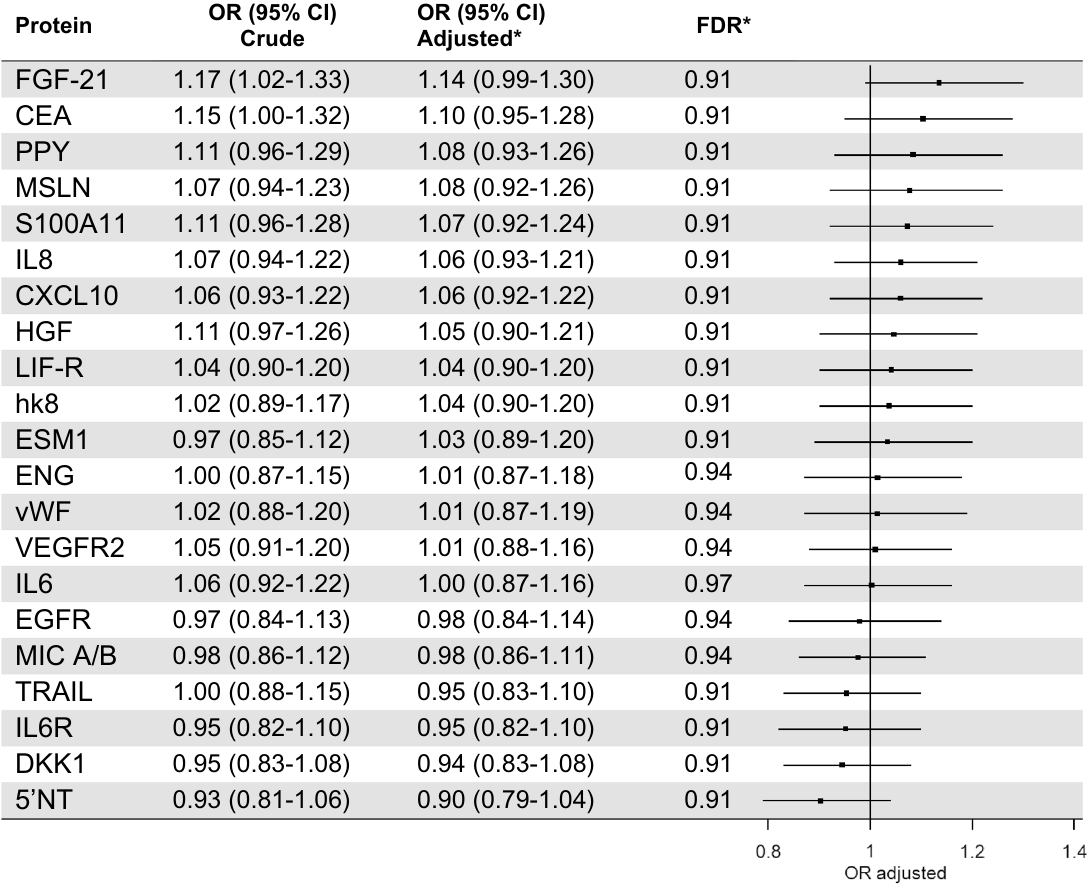
Table 3. Proteins included in the validation phase main analysis. *Adjusted for BMI, smoking and education and conditioned on matching criteria (age, sex and sampling